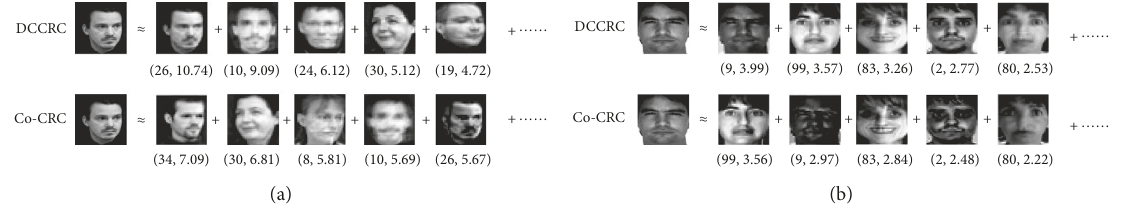
Figure 4: The reconstructive images of the given testing samples by the classes with the top five largest representation contributions via DCCRC and Co-CRC on the face databases (a) IMM and (b)